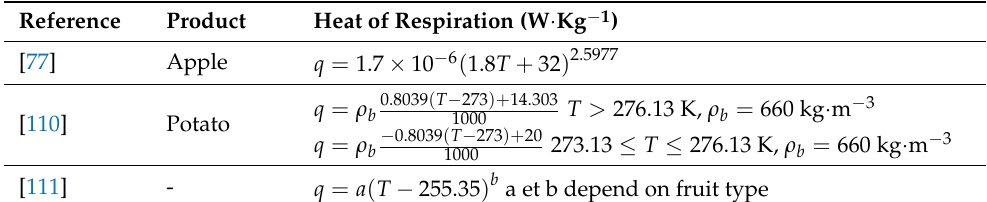
Table 6. Correlations for the heat of respiration as a function of temperature. Data extracted from